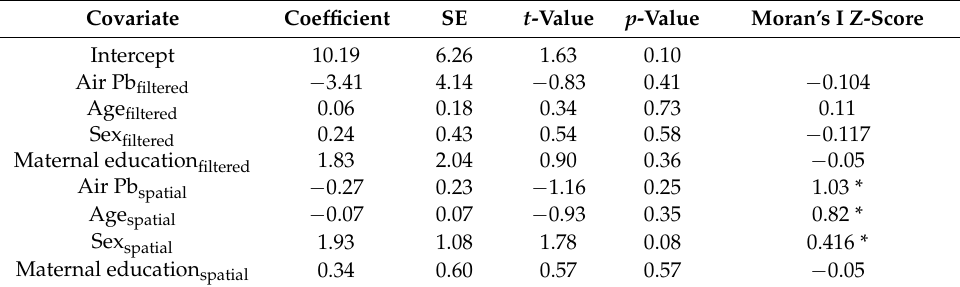
Table 5. Spatially filtered regression results for the model evaluating the relationship between blood lead levels (BLLs) and air lead (Pb) concentrations, estimated for each cohort member by its nearest residential air sample and adjusted for age, sex, and maternal education.